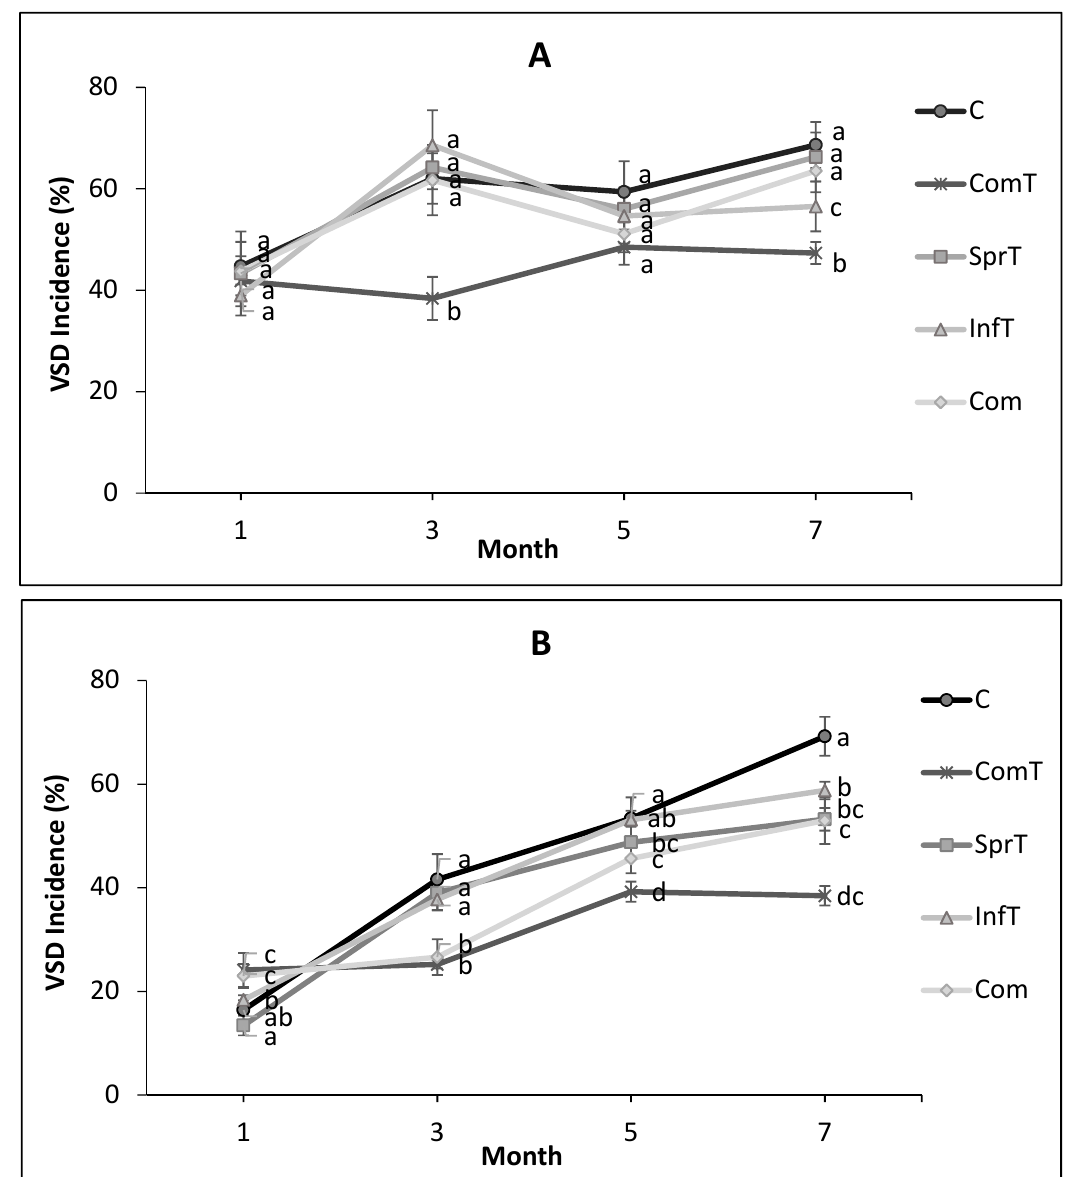
Figure 2. Dynamic of vascular streak dieback disease incidence on cacao heavy infected after treatment withcomposted plant residues and Trichoderma asperellum in the first year ( A ) and in the second year ( B ). C = control, ComT = compost plus Trichoderma , SprT = spraying of Trichoderma , InfT = infusion of Trichoderma , Com = compost. Means of incidence at the same time followed by the same letter are not significantly different according to LSDtest ( p ≤ 0.05).